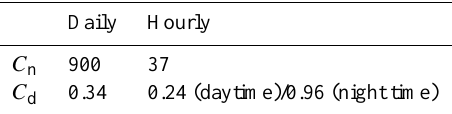
Table 1. Resistance coefficient values in ASCE-PM equation (Gavil´an et al.,